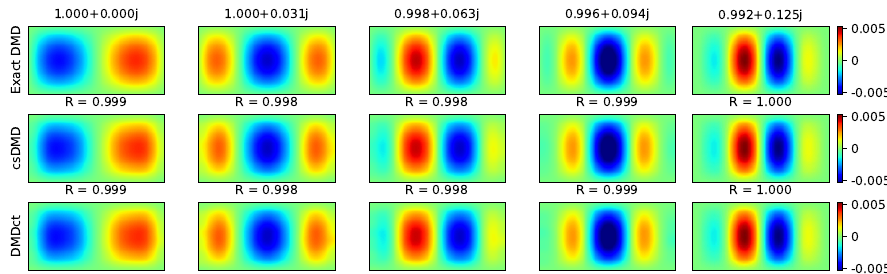
Figure 2. The real parts of the mode shapes of the first five DMD modes corresponding to the eigenvalues with non-negative imaginary parts for the double-gyre dataset. The top row shows the mode shapes obtained by applying exact DMD on the fully-sampled dataset. The second and third rows show the aligned csDMD and DMDct reconstructions, respectively. The corresponding eigenvalues are represented above the columns. The Pearson correlation coefficients between the aligned reconstructed mode shapes and those of exact DMD are shown as well.